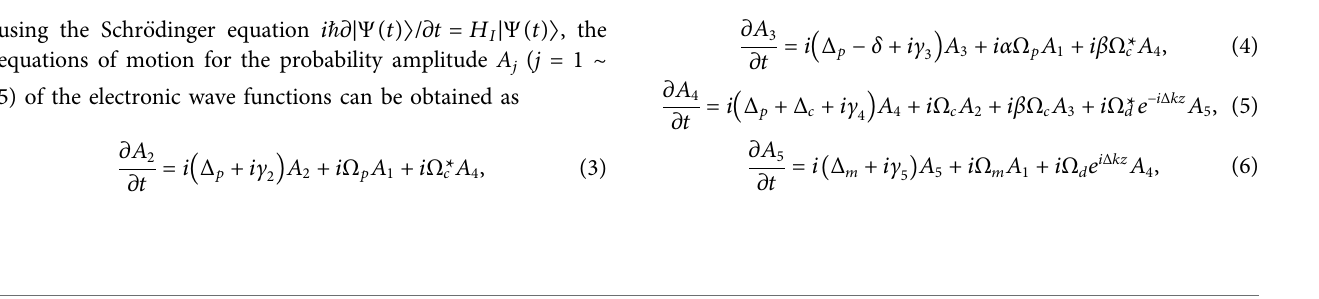
Frontiers in Physics |